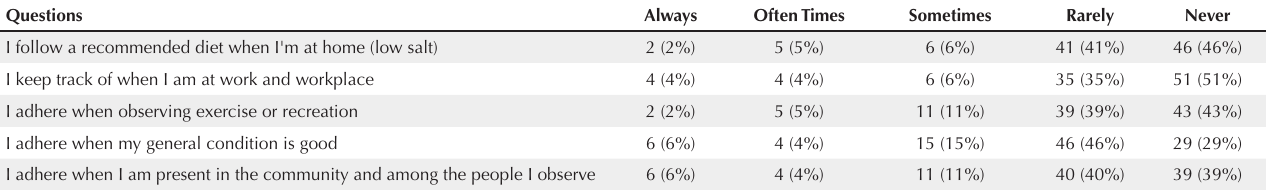
Table 3. Questions and Percentage of Response Relevant to Diet Follow-up of Patients With Hypertension